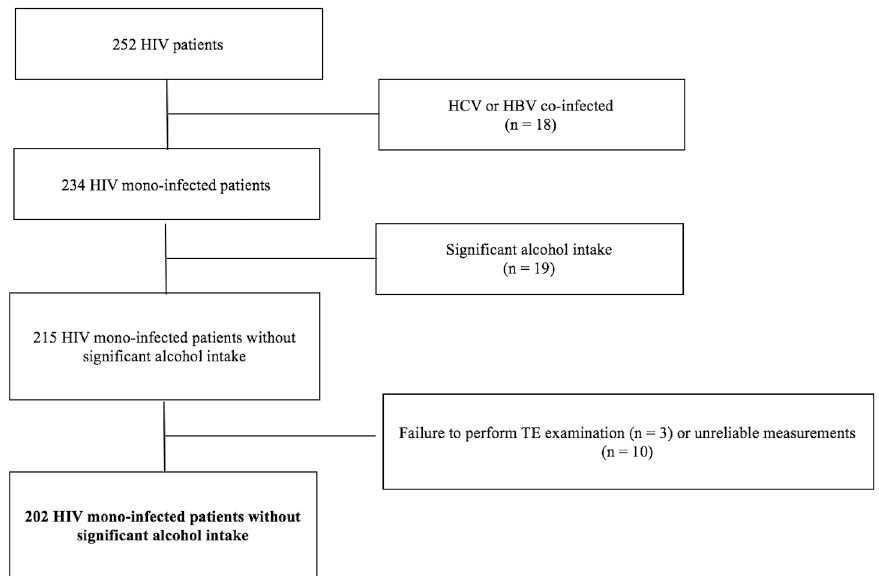
Fig 1. Flow chart displaying selection of study participants for analysis. Of 252 consecutive HIV patients who had a TE examination done at the Chronic Viral Illness Service and had available lab data, 18 were excluded because they were co-infected with HCV or HBV, 19 because of significant alcohol intake, 3 because of failure to perform TE examination and 10 because of unreliable measurements. Abbreviations: HIV, human immunodeficiency virus; HCV, hepatitis C virus; HBV, hepatitis B virus; TE, transient